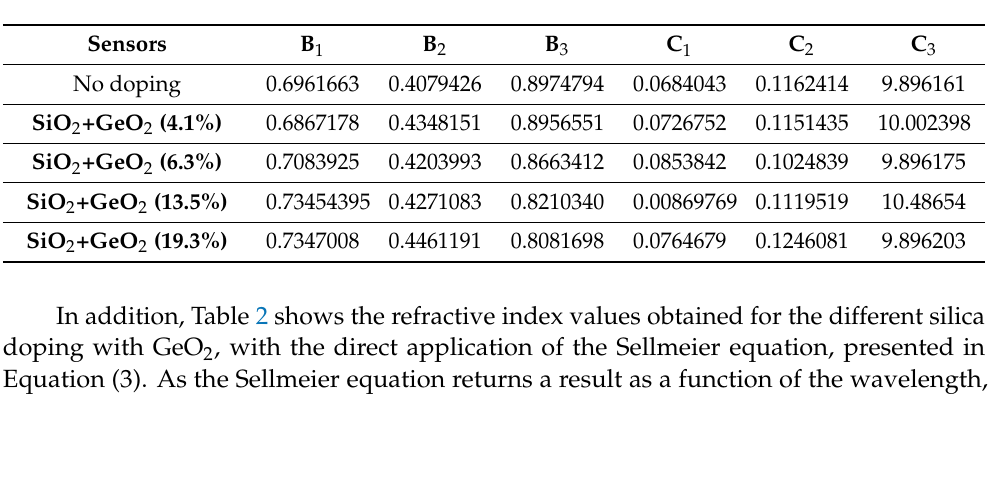
Table 1. Sellmeier